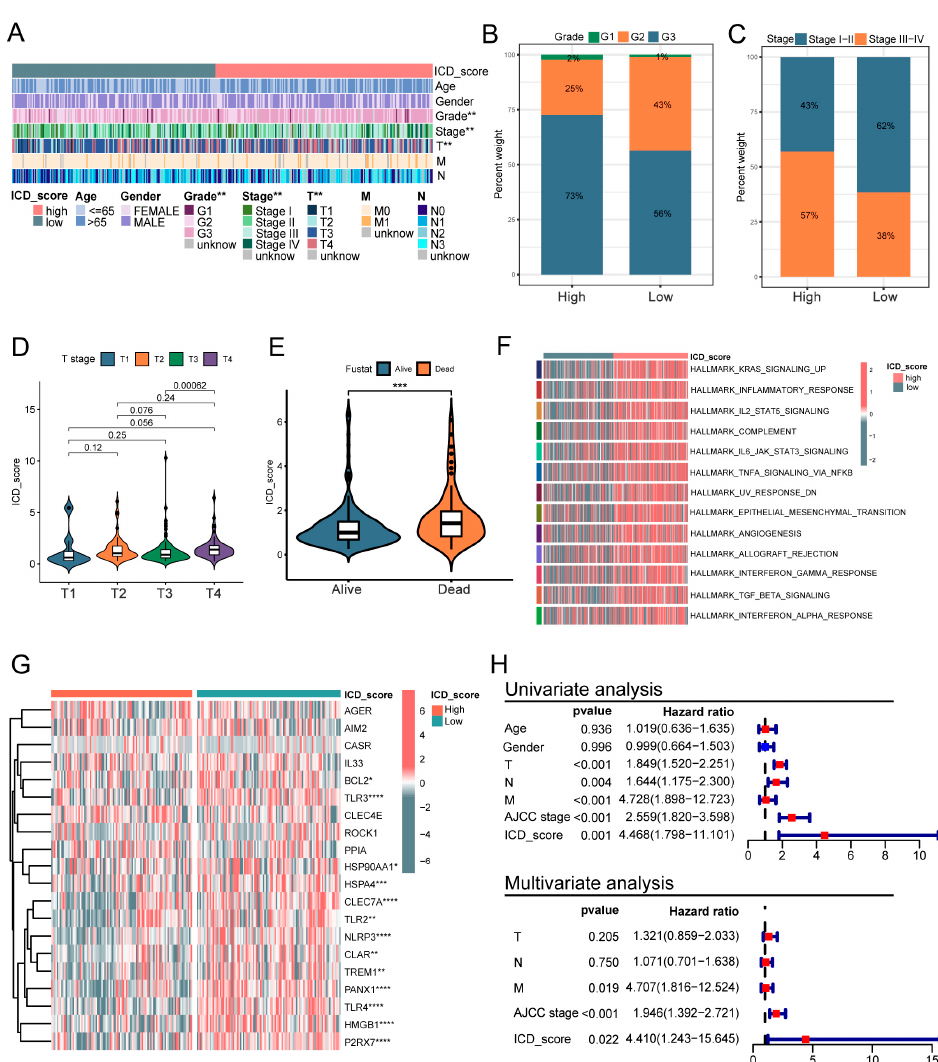
Figure 6. Comprehensive analysis of the ICD_score in GC. ( A ) Relationships between clinicopatho- logic features and the two ICD_score groups. ( B , C ) Correlations between ICD_score and tumor grade and stage in TCGA cohort, respectively. ( D ) ICD_scores of patients with different T-category in TCGA cohort. ( E ) ICD_scores of GC patients with different survival statuses. ( F ) GSVA of hallmark pathways between two distinct ICD_score groups, in which red and grey represent activated and inhibited pathways, respectively. ( G ) Expression pattern of DAMPs-related genes in different ICD_score group. ( H ) Univariate and multivariate Cox regression analysis regarding OS in our cohort. p values were shown as: * p < 0.05; ** p < 0.01; *** p < 0.001; **** p < 0.0001. GSVA, gene set variation analysis; DAMPs, damage-associated molecular